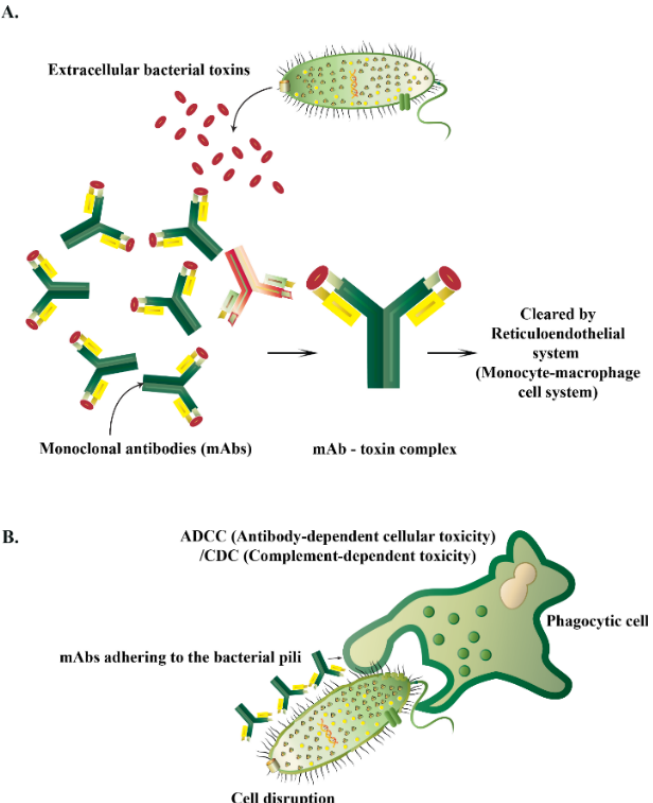
Figure 6. Monoclonal antibodies’ (mAbs) mode of action. ( A ) Depicts the neutralization of bacterial toxin by mAbs. Bacterial toxins are secreted by bacteria. The antibodies attach to the toxins and get cleared by the reticuloendothelial system. The reticuloendothelial system is a cluster of phagocytes that clear matter. ( B ) mAbs adhere to the pili structures of the bacteria. Pili are hair-like appendages found on the surface of many bacteria that function to attach cells to surfaces. The antibodies attach along with the phagocytic cells (antibody-dependent cellular cytotoxicity—ADCC) and/or complement (complement-dependent cytotoxicity—CDC) and eventually cause the bactericidal effect.